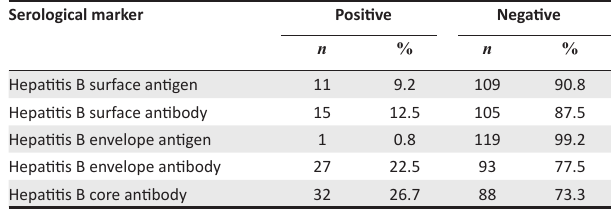
TABLE 2: Seroprevalence of hepatitis B serological markers † among HIV-positive adult patients attending the Jos University Teaching Hospital HIV clinic, August